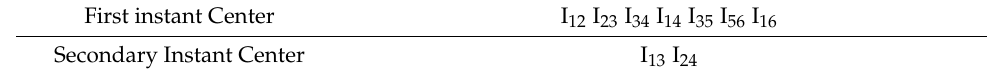
Table 1. Instant centers of the Stephenson linkage.